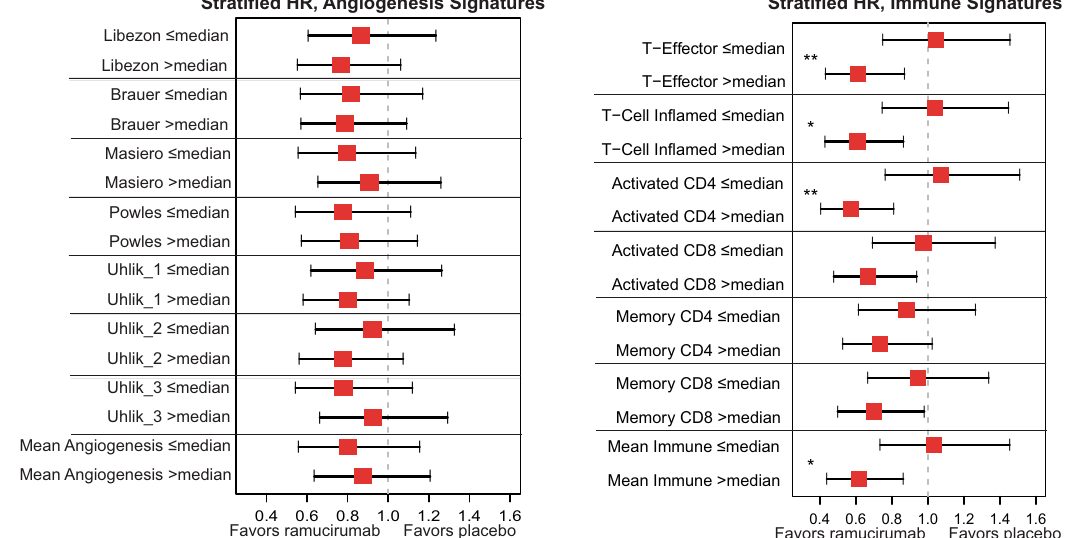
Fig. 2 Molecular subtype association with PD-L1 status, angiogenesis/immune signatures, and clinical outcome. a Heatmap of angiogenesis and immune gene signatures in the TR2 population ( n = 394 participants). Columns (patient samples) are ordered by CPS PD-L1 group (CPS not measured, CPS 0 – 9 and CPS 10 – 96) and by region (East Asia, Europe/Other, and North America). b Mean signature score for angiogenesis and immune pathways in CPS < 10 ( n = 126) vs. CPS ≥ 10 ( n = 101) samples from n = 227 participants in the TR1 population. For boxplots, the center line represents median, box hinges represent fi rst and third quartiles, whiskers represent minimum and maximum within 1.5x interquartile range, and red marker is mean. Mean angiogenesis signature score, p = 0.009 (CPS < 10 vs. CPS ≥ 10, two-sample t -test without multiplicity adjustment). Mean immune signature score, p < 0.0001 (CPS < 10 vs. CPS ≥ 10, two-sample t -test without multiplicity adjustment). c Forest plot of strati fi ed OS HRs (95% CIs) of ramucirumab + docetaxel vs. placebo + docetaxel for the subgroups de fi ned by dichotomized individual angiogenesis and immune signatures, and corresponding mean of angiogenesis and immune signature score. Data are presented as estimated HR with error bars indicating the 95% CI. Each signature is dichotomized by the median. Citations for the angiogenesis signature pathways can be found in the Methods and Supplementary Table 2. Strati fi cation was based on geographical region, baseline ECOG PS, and visceral metastases. The proportional hazard assumption was not violated in any instance. The TR2 population ( n = 394 participants) was used; n = 197 participants within each subgroup. *Interaction p -value < 0.1 (0.055 for T-cell in fl amed; 0.063 for mean immune); **Interaction p -value < 0.05 (0.036 for T-effector; 0.022 for activated CD4). p -values were based on two-sided Wald test without multiplicity adjustment. Source data are provided as a Source Data fi le. CI, con fi dence interval; CPS, combined positive score; CR, complete response; HR, hazard ratio; IC, immune cell; n, number of participants; NE, not evaluable; PD, progressive disease; PD-L1, programmed cell death ligand 1; PR, partial response; SD, stable disease; TC, tumor